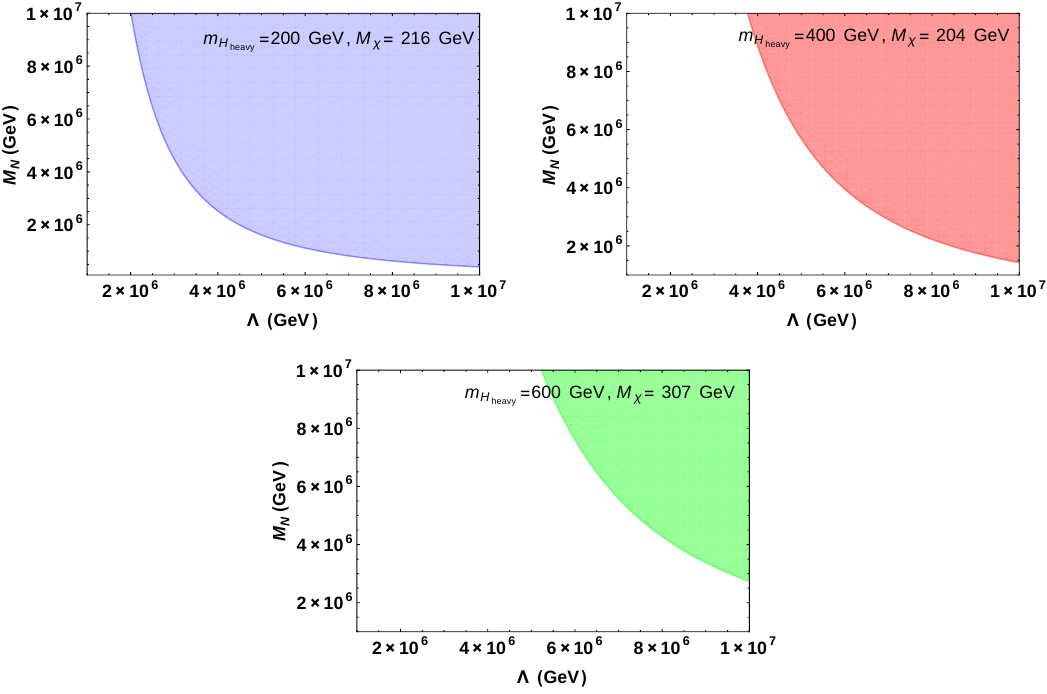
Figure 12 . Correlation between right handed neutrino mass M N and cut-o(cid:11) scale (cid:3) for successful generation of light neutrino masses for di(cid:11)erent choices of heavy Higgs mass m H 600 GeV, which points out to certain de(cid:12)nite choices of DM masses as M (cid:31) = 216, 204, 307 GeV respectively (corresponding to sin (cid:18) = 0 : 011 ; 0 : 115 ; 0 : 119) to satisfy relic density and direct search constraints together with perturbative